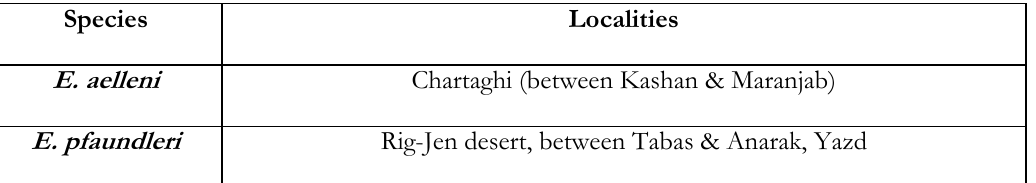
T ABLE 1. - The distribution of Erodiontes spp. in the Lute desert(Kaszab, 1979). Species Localities E. aelleni Chartaghi (between Kashan & Maranjab) E. pfaundleri Rig-Jen desert, between Tabas & Anarak, Yazd